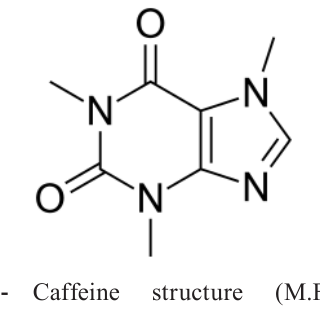
FIGURE 1 - Caffeine structure (M.F:C8H10N4O2,